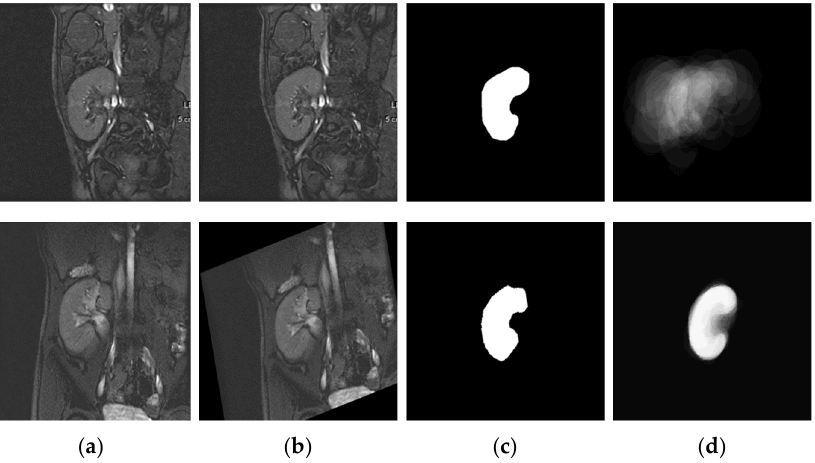
Figure 6. Illustration of the adopted strategy for SP-model construction: ( a ) sample training DCE-MRIs, ( b ) affine-registered DCE-MRIs, ( c ) manually segmented kidneys, and ( d ) the SP-model built from non-registered ( top ) and from affine-registered ( bottom ) DCE-MRIs.